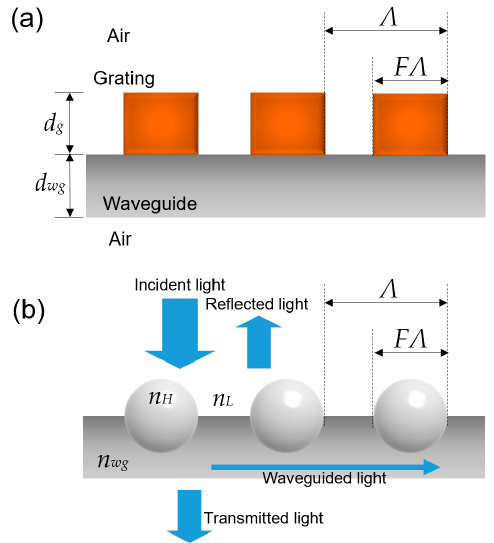
Figure 1. Simulated structure of the GMR device of ( a ) rectangular and ( b ) spherical shapes.